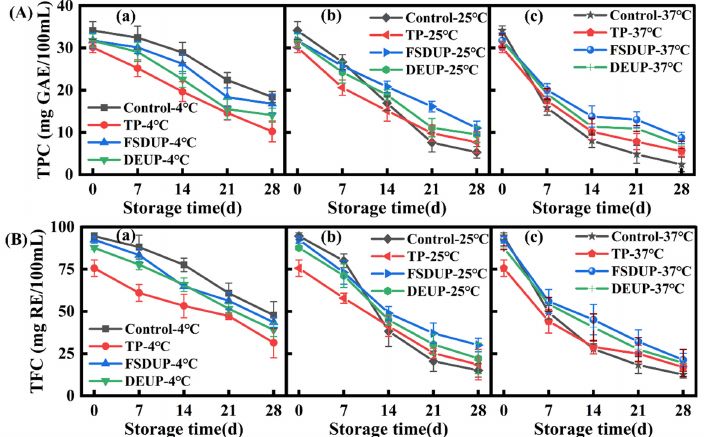
Figure 4. Changes in total phenolic content ( A ) and total flavonoid content ( B ) of strawberry clear juice during storage after thermal pretreatment and multi-mode thermosonication. TPC: total phe- nolic content; TFC: total flavonoid content; TP: thermal pretreatment; FSDUP: flat sweep-frequency dispersive ultrasound pretreatment; DEUP: dual-frequency energy-gathered ultrasound pretreat-